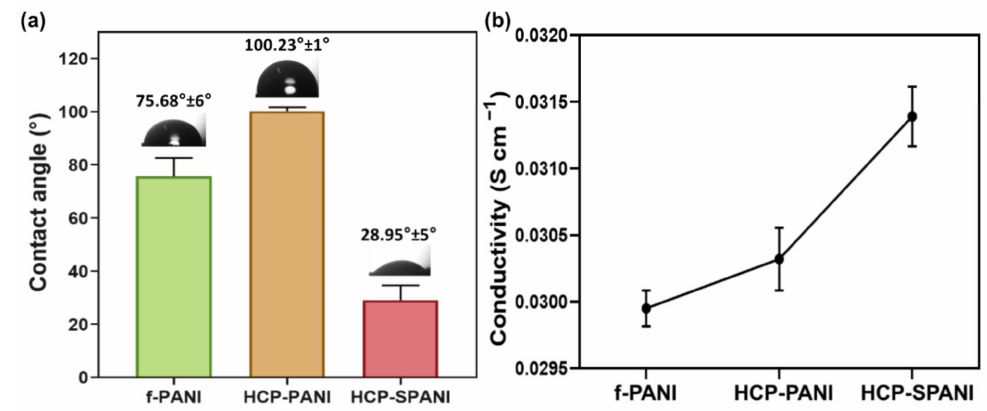
Figure 6. ( a ) Water contact angle and ( b ) conductivity of f-PANI, HCP-PANI, and HCP-SPANI